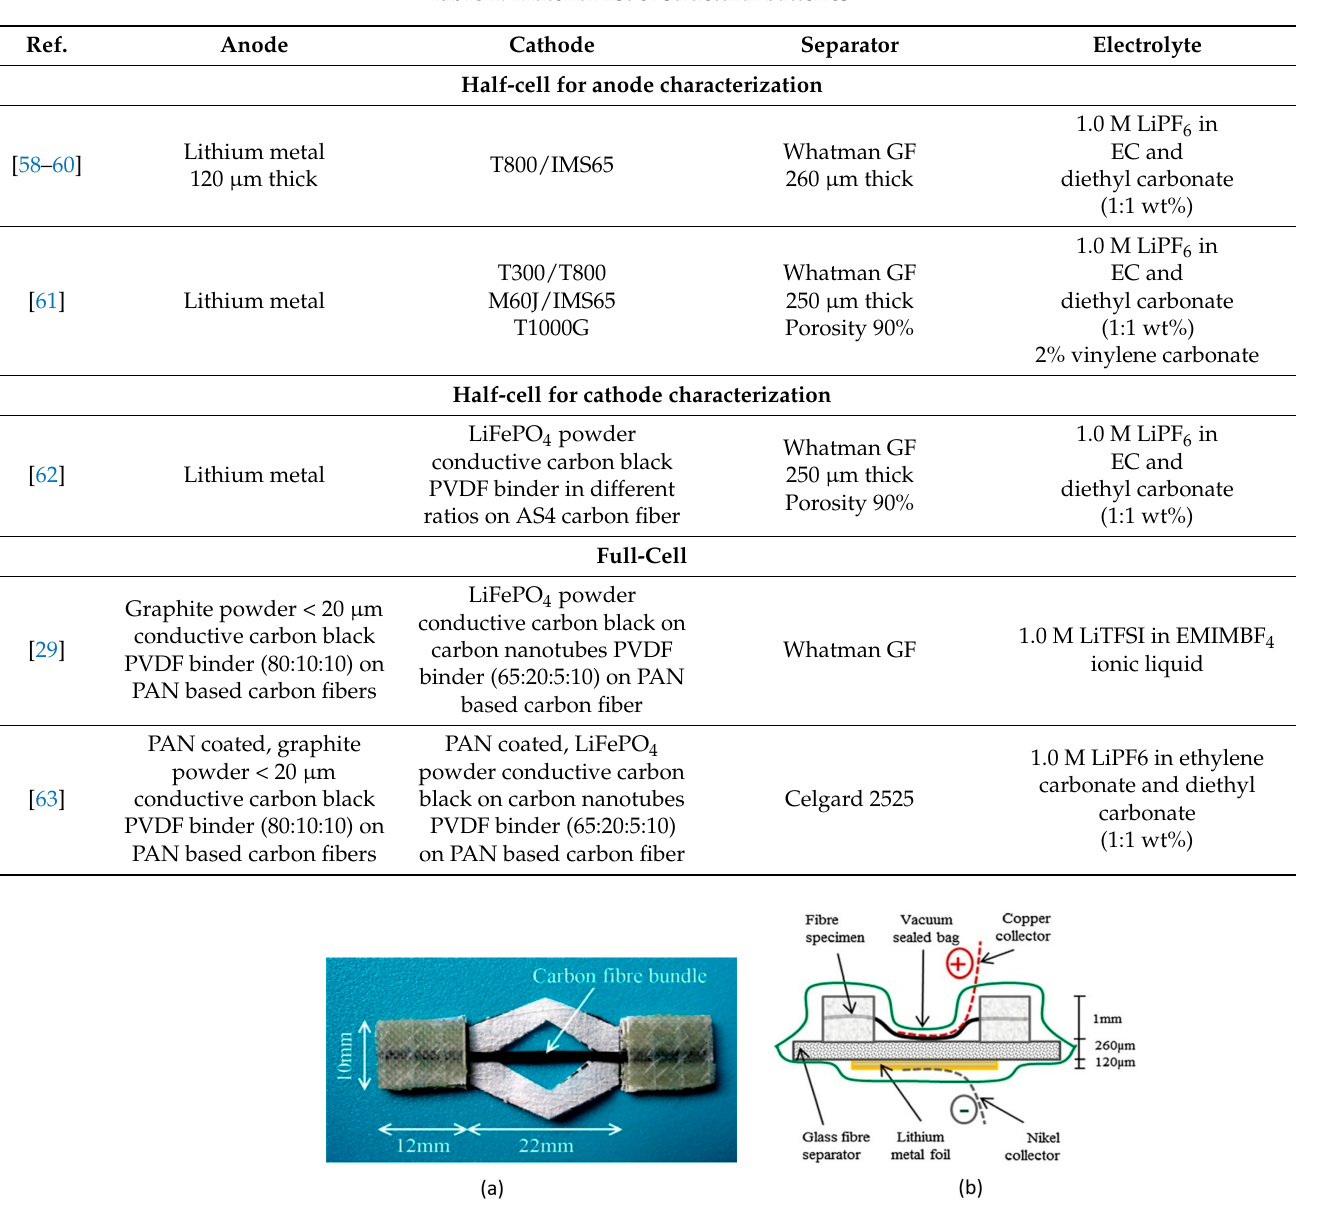
Figure 16. Fiber set-up [58]. ( a ) Tensile specimen. ( b ) Electrochemical cell.